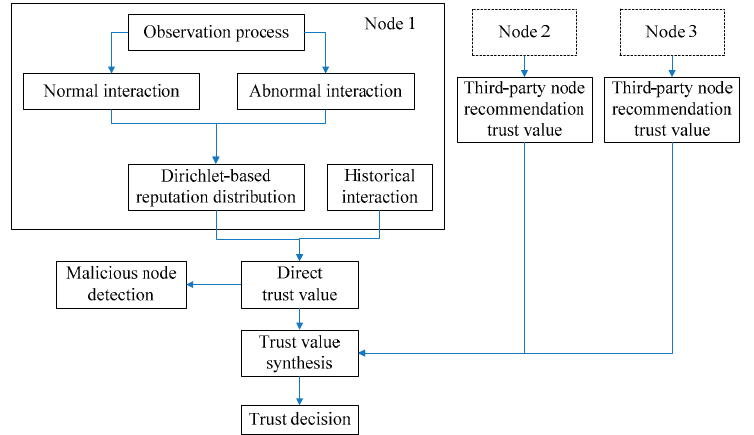
Figure 1. Flow chart for DDTMS design.